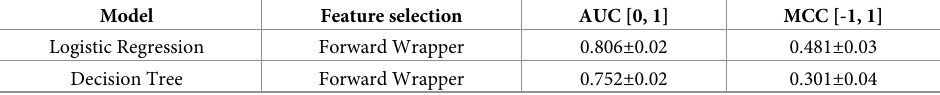
Table 3. Comparison between Logistic Regression and Decision Trees with the Forward Wrapper